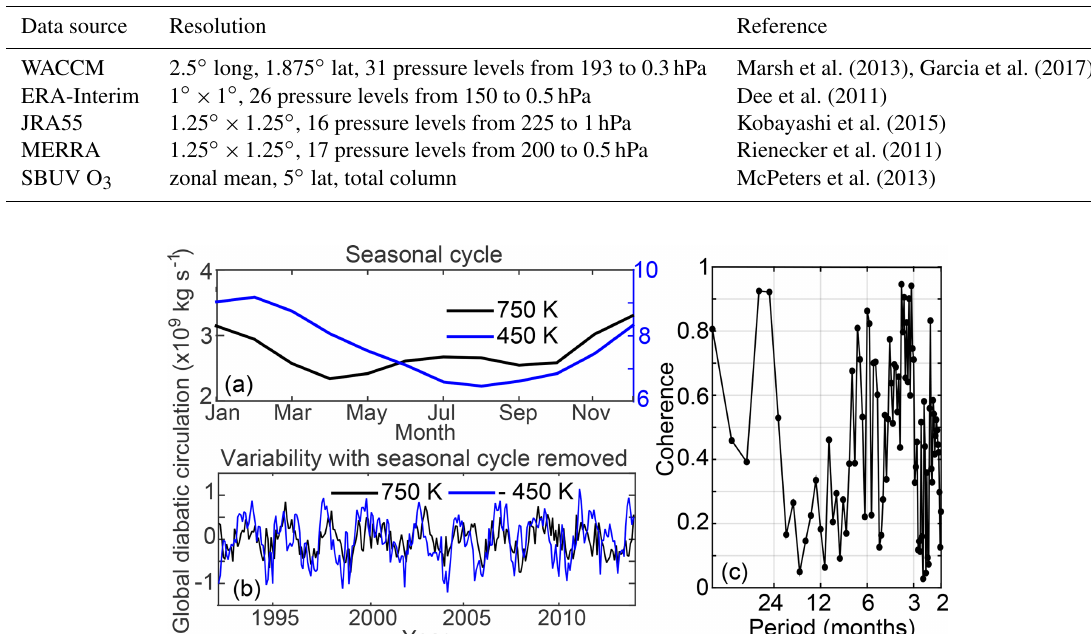
Figure 1. The seasonal cycle (a) and interannual variability (b) for the 450K global diabatic circulation and the 750K global diabatic circulation in the WACCM model from 1980 to 2014. Note that in (b) the sign of the anomalies has been reversed for the 450K level in order to see the agreement. Panel (c) shows the coherence between these two time series, demonstrating that the visual correlation evident in (b) is related both to the quasi-biennial oscillation and to higher